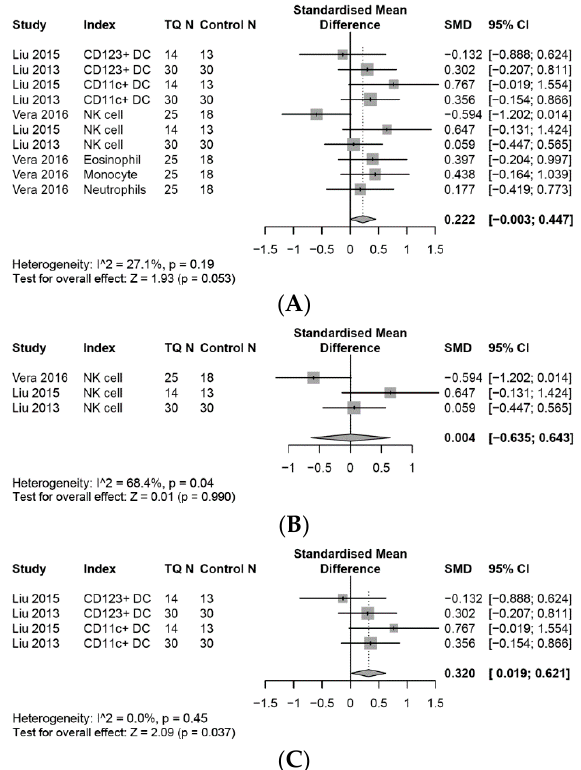
Figure 3. Forest plot for random-effects meta-analysis of the effects of TQ on the innate immune system. ( A ): The effects on the innate immune system, ( B ): the effects on the NK cells, ( C ): the effects on the DCs.